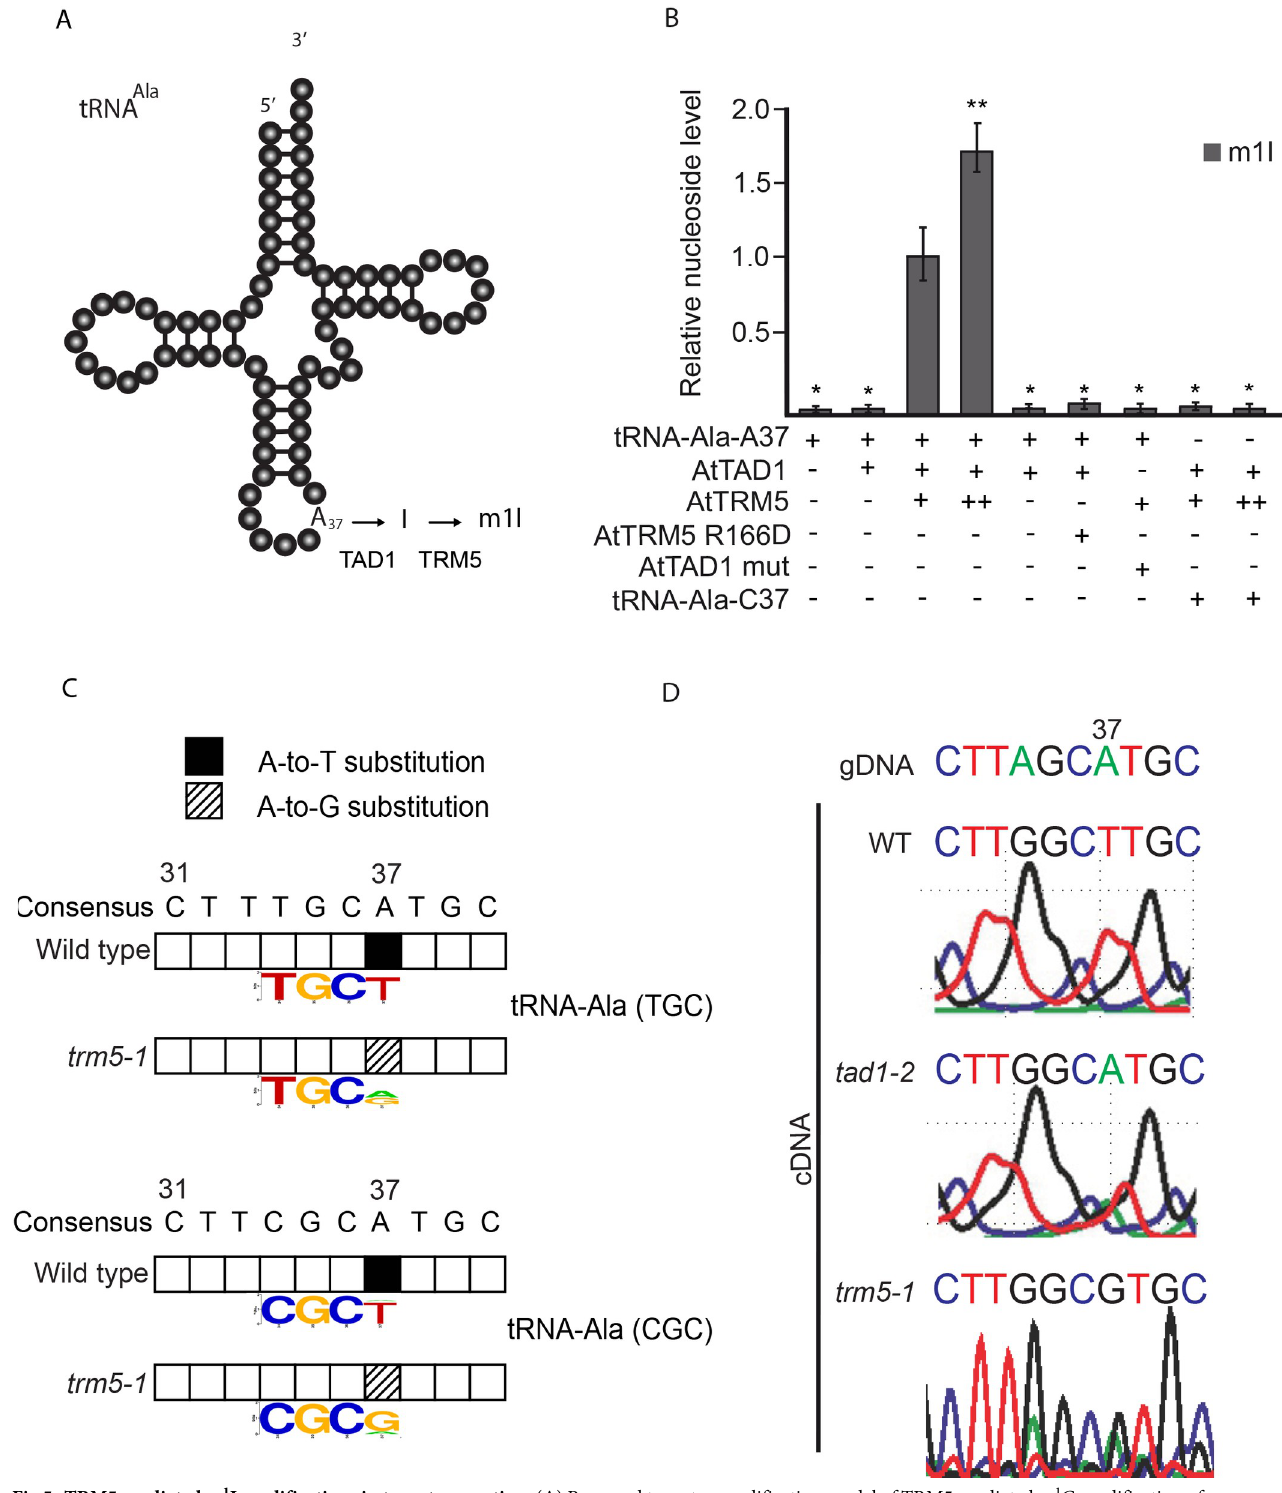
Fig 5. TRM5-mediated m 1 I modifications in two-step reaction. ( A ) Proposed two-step modification model of TRM5-mediated m 1 G modification of tRNA-Ala. ( B ) Relative nucleoside level of modification m 1 I with varying conditions of tRNA-Asp-A37, AtTAD1, AtTRM5 mutant, AtTAD1 mutant, and tRNA-Ala-C37. + indicates presence, ++ indicates two-fold increase,—indicates absence. ( C ) Qualitative analysis of tRNA-Ala (TGC) and tRNA-Ala (CGC) modifications. tRNAs were enriched, deep sequenced, aligned using segemehl to tRNA references and the modifications present were inferred from observed